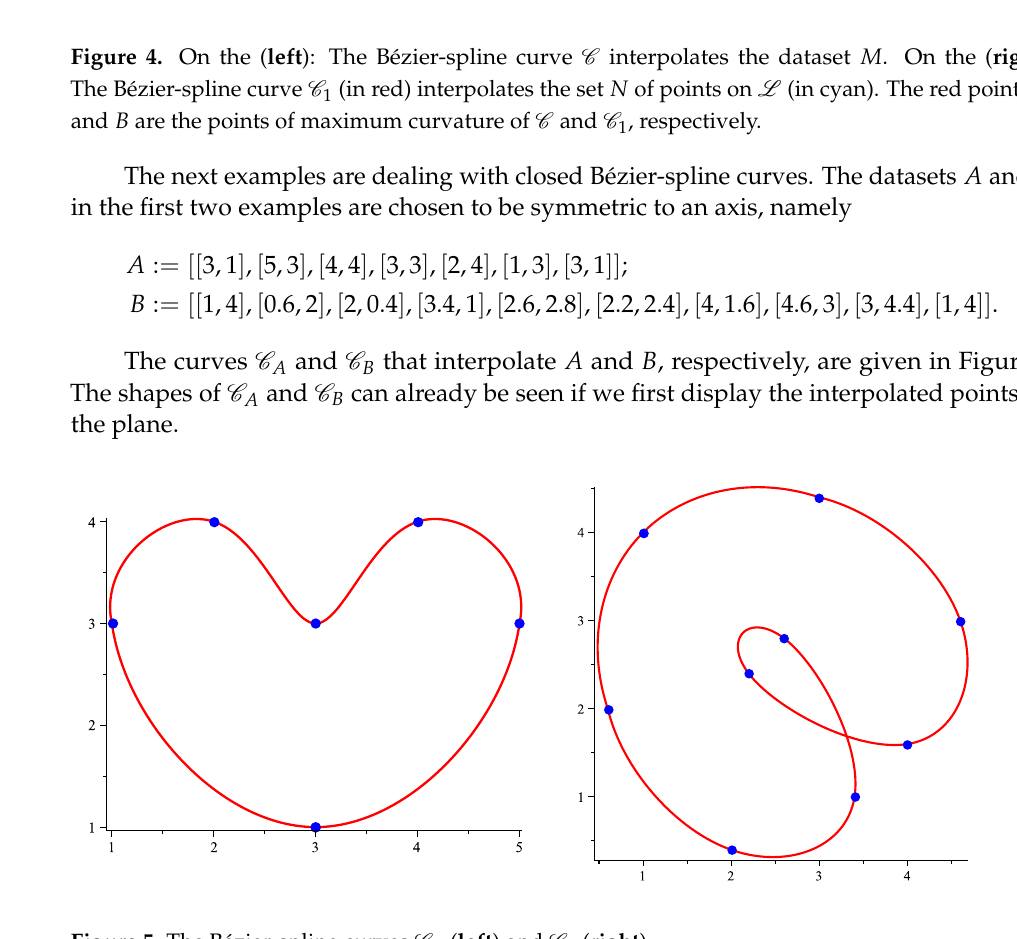
Figure 5. The Bézier-spline curves C A ( left ) and C B ( right